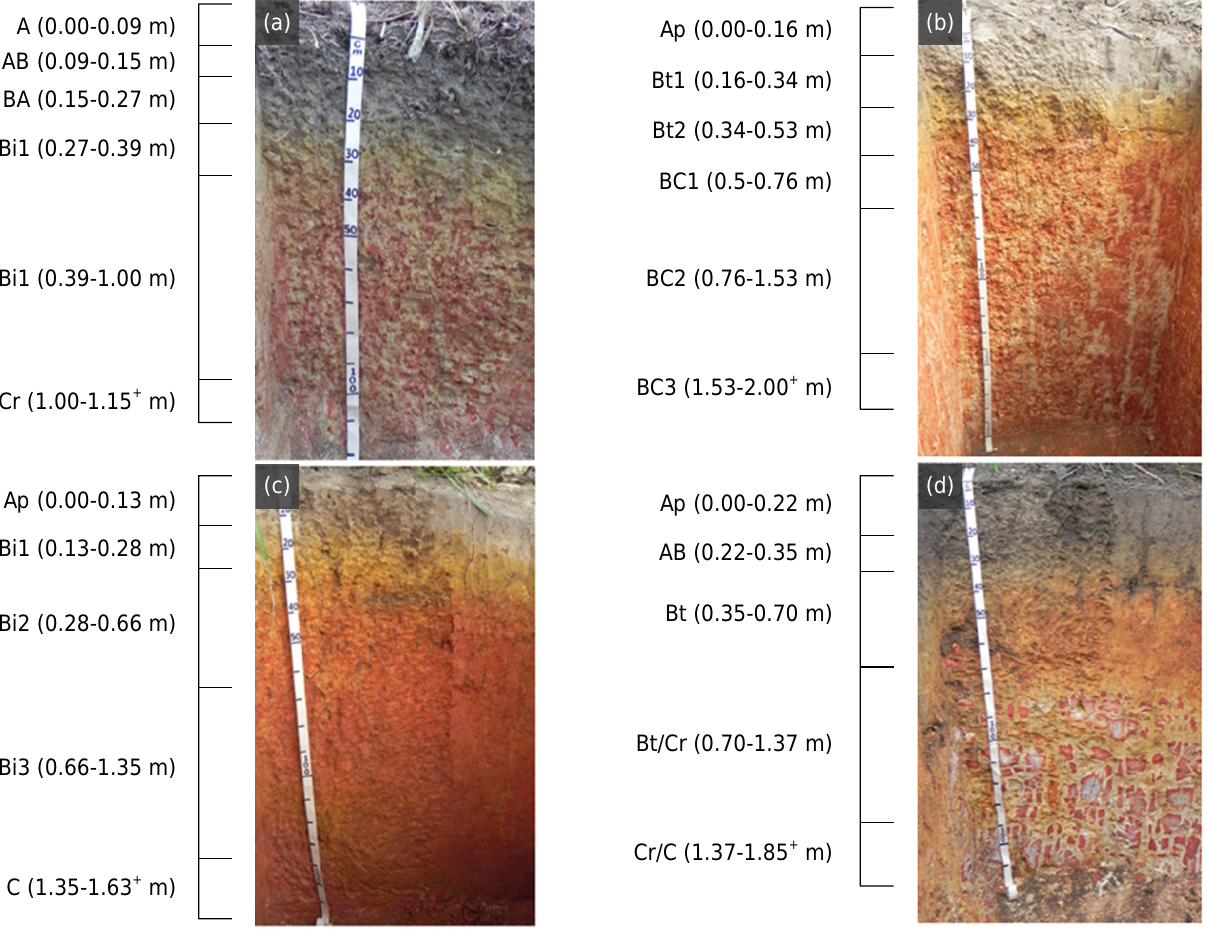
Figure 2. Image of the profiles. (a) Profile 1: Cambissolo Háplico Tb Distrófico típico (SiBCS), Haplic Cambisol (WRB), or Haplustept (Soil Taxonomy); (b) Profile 2: Argissolo Vermelho-Amarelo Distrófico abrúptico (SiBCS), Abruptic Lixisol (WRB), or Hapludult (Soil Taxonomy); (c) Profile 3: Argissolo Vermelho-Amarelo Distrófico típico (SiBCS), Haplic Lixisol (WRB), or Hapludult (Soil Taxonomy); and (d) Profile 4: Argissolo Vermelho-Amarelo Distrófico típico (SiBCS), Haplic Lixisol (WRB), or Hapludult (Soil